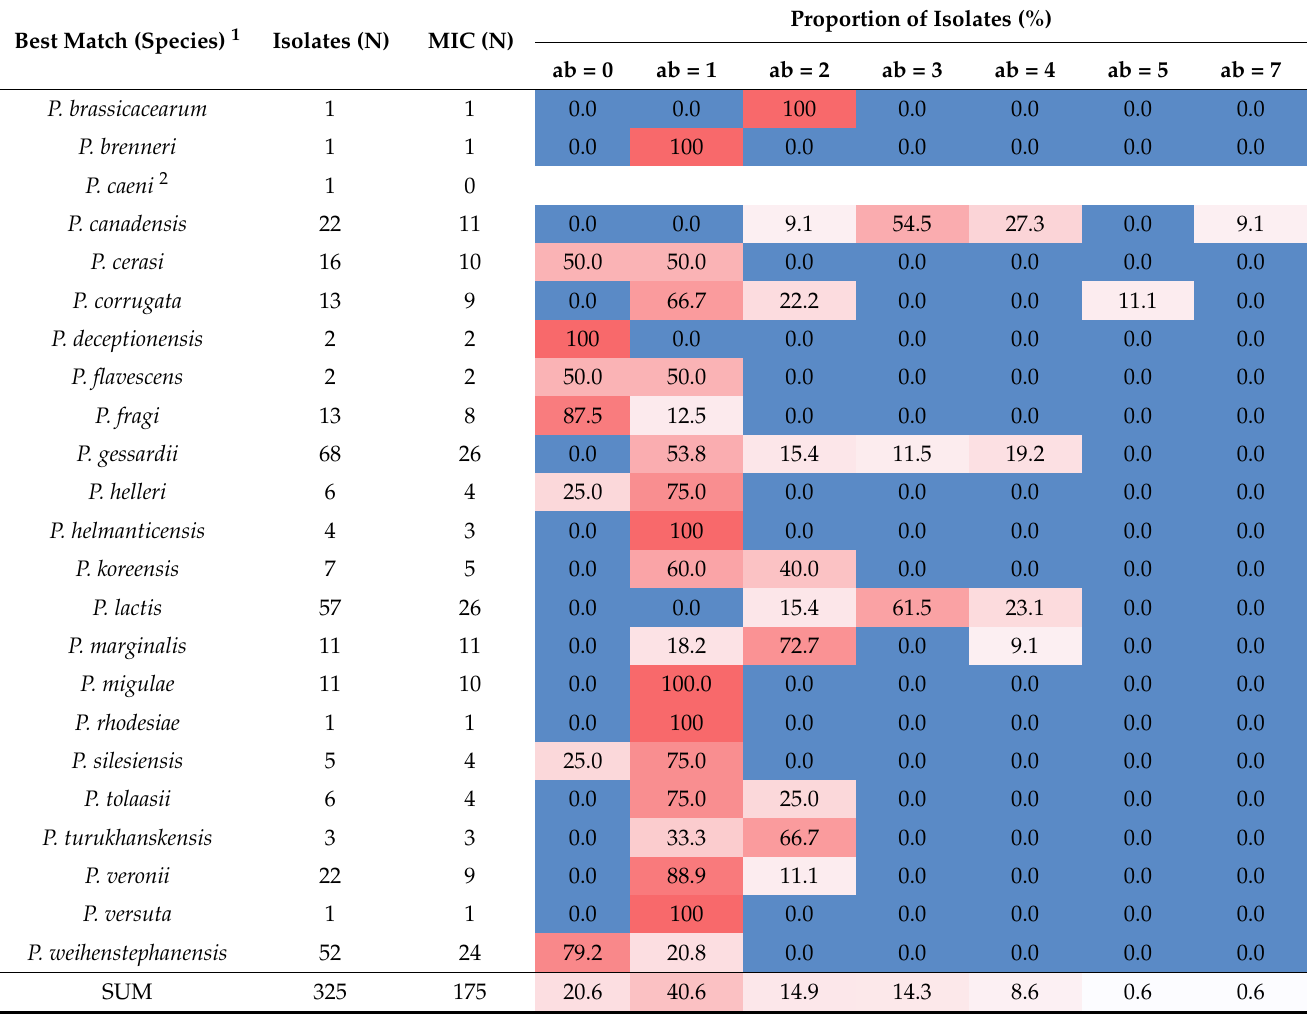
1 Best match based on 288 bp og the 16S rRNA gene and the BLAST 16S rRNA (bacterial and archaea type strains) database. 2 This isolate was not viable when selected for MIC testing. Three isolates (collection 3A ( P. corrugata ) and 3B ( P. gessardii and P. weihenstephanensis )) harbored genes for intI 1 class 1 integrons although with empty cassettes. No intI 2 class 2 integrons were